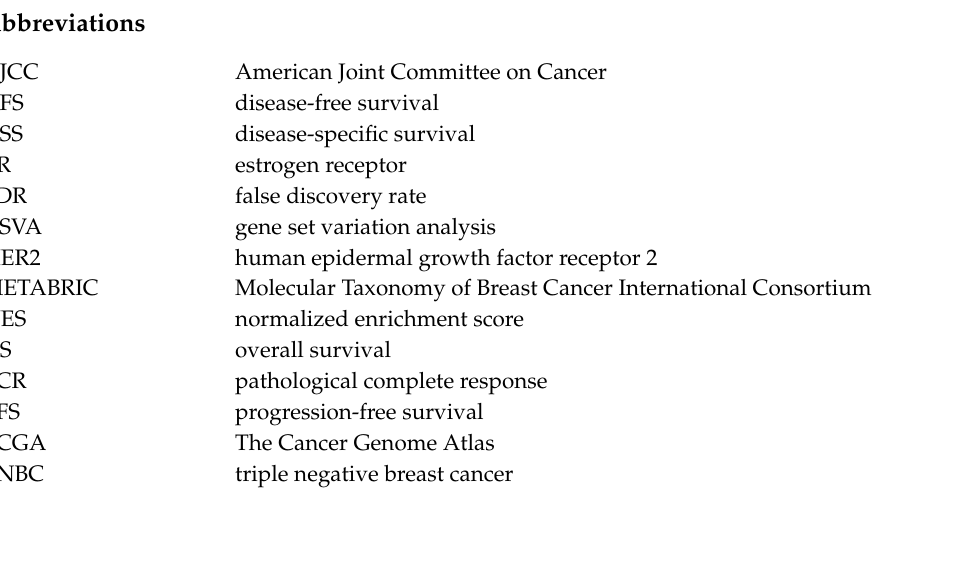
Table S1: Member genes of the Angiogenesis pathway score. Figure S1: Histogram of angiogenesis score patient distribution in the TCGA and METABRIC cohorts. Figure S2: Expression of specific tumor suppressor and Notch genes in tumors with low and high angiogenesis pathway scores. Figure S3: Association between the angiogenesis pathway score and survival of breast cancer patients in the METABRIC